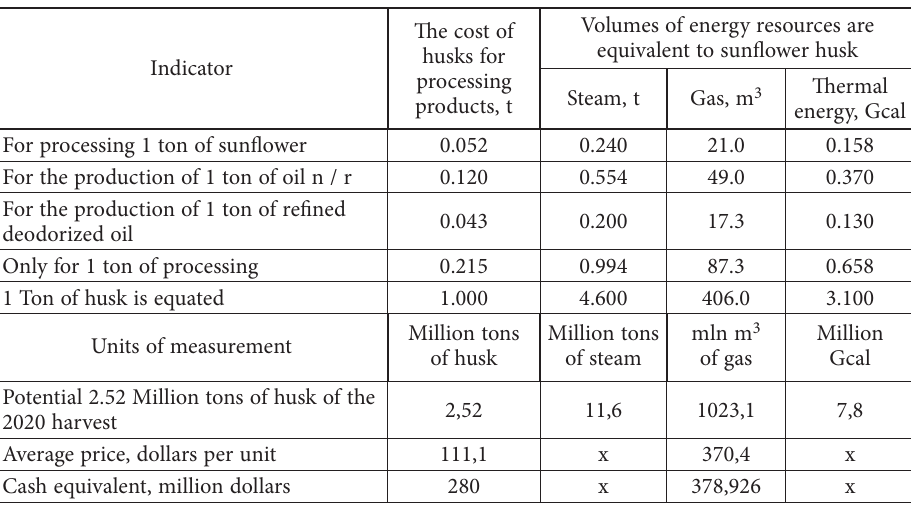
In Table 2, the calorific value of 2.52 million tons of sunflower husk emits was evaluated as much heat as 2.99 million tons of wood fuel, 1.02 billion m 3 of natural gas, 0.98 million